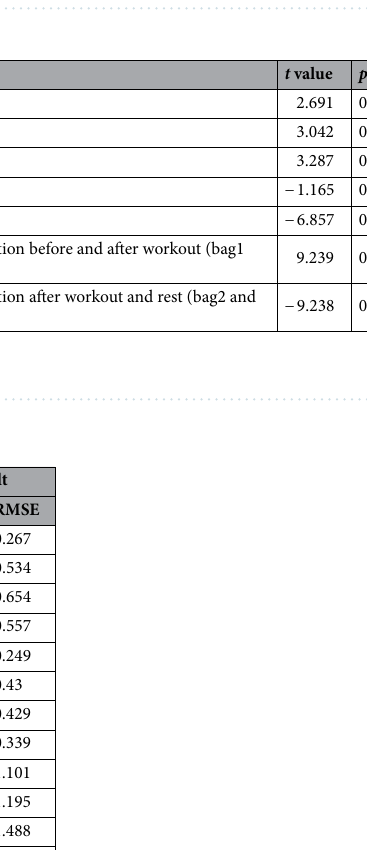
Figure 6. Mean DMS concentration (ppb) difference from collected exhaled breath of patient and healthy group.